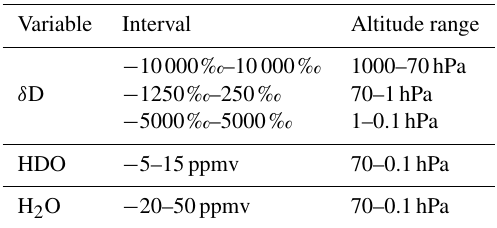
Table 1. Interval screening performed prior to the comparisons. Pro- files that exhibited data points outside of these intervals were dis-